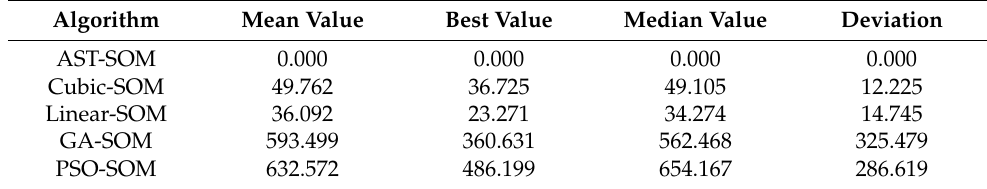
Table 5. The statistical results of all comparative methods with ten independent runs.